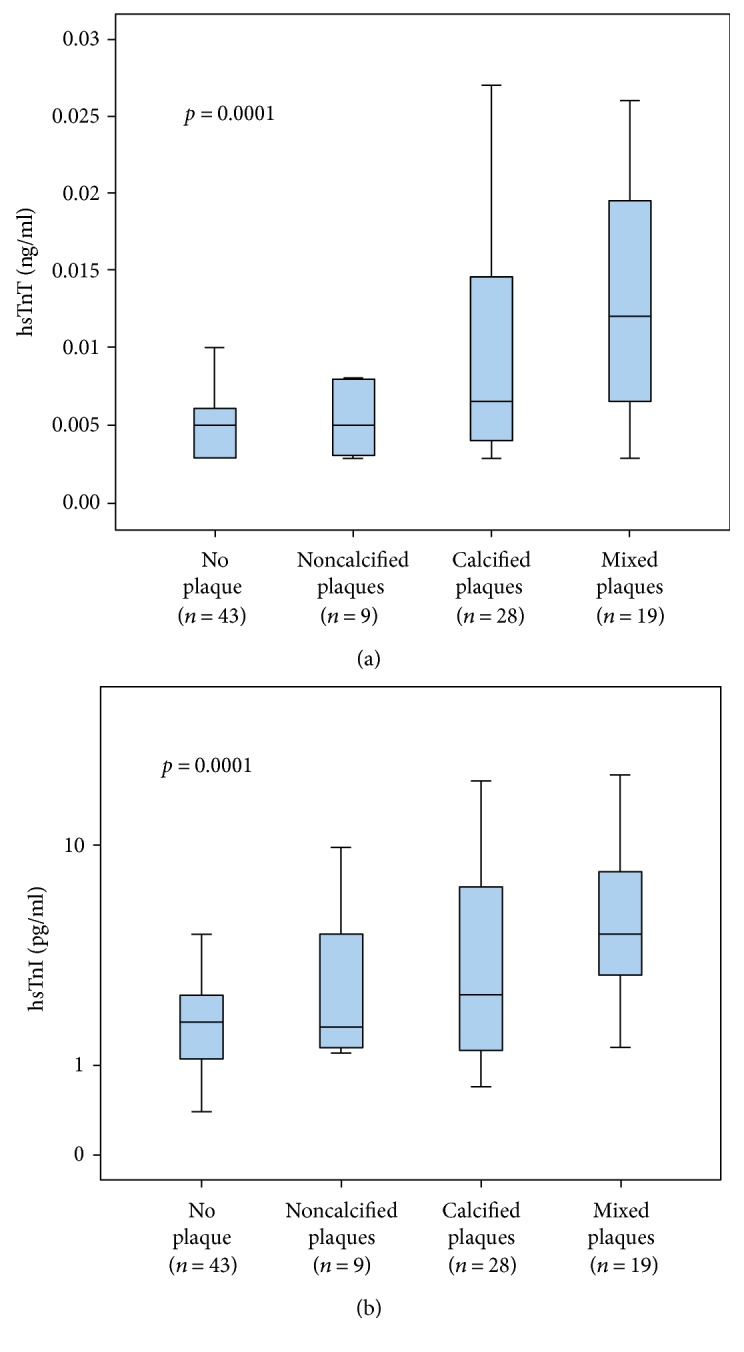
Boxplots illustrating significantly increasing levels of hsTnT (a) and hsTnI (b) in the following groups: no plaques, noncalcified plaques, calcified plaques, and mixed plaques.